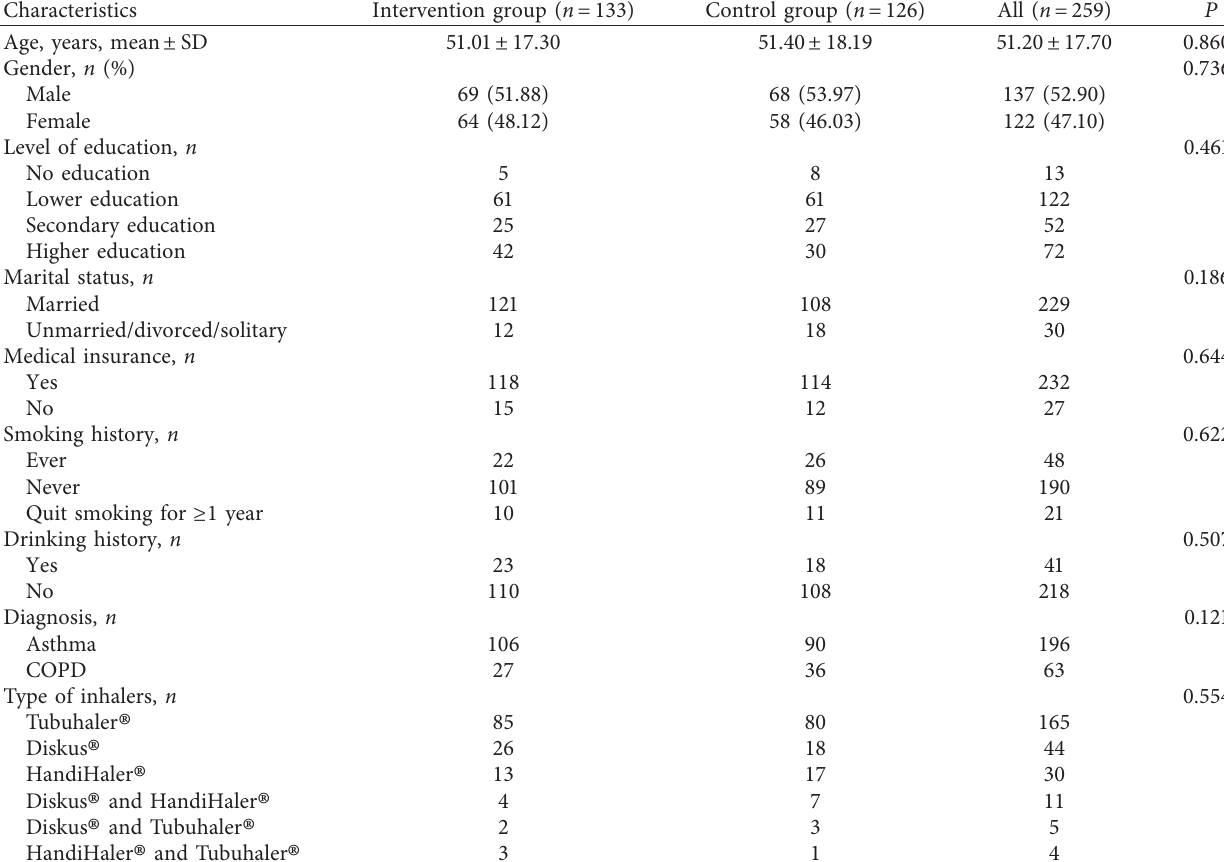
Table 2: Demographic characteristics of asthma and COPD